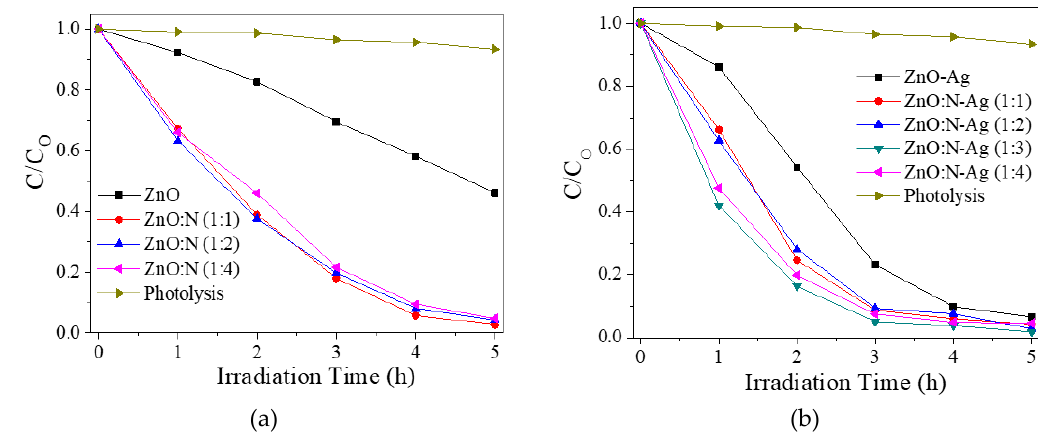
Figure 7. Variation of the photocatalytic e ffi ciency of ( a ) pure ZnO and ZnO:N NRs and ( b ) ZnO-Ag and ZnO:N-Ag NRs. Uncertainty associated with each measurement is 5%.